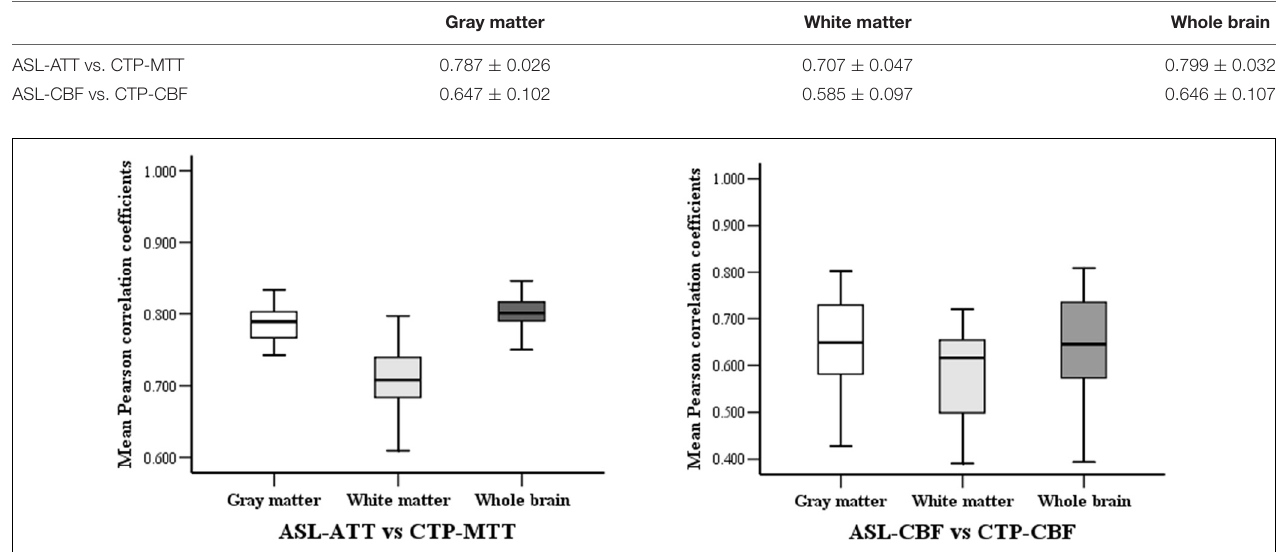
FIGURE 2 | The box-plots of mean Pearson correlation coefficients between the two modalities in gray, white matter and whole